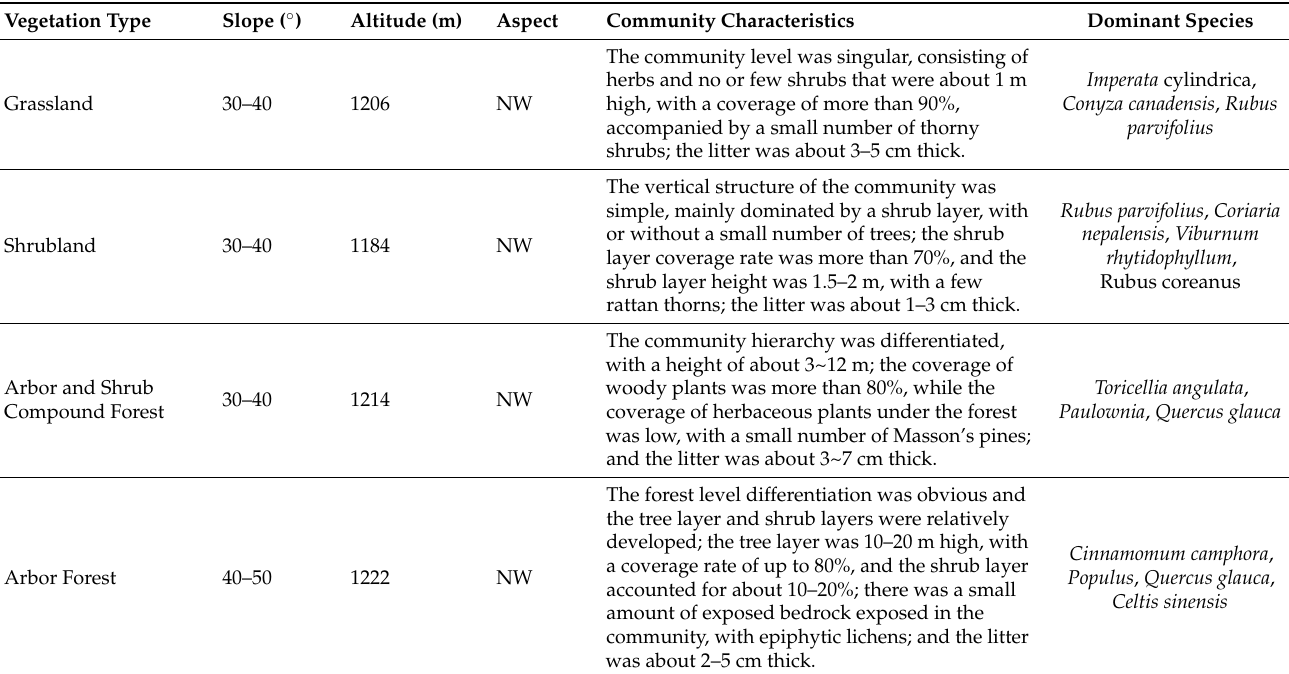
Table 1. A basic overview of the sample plots of the various vegetation